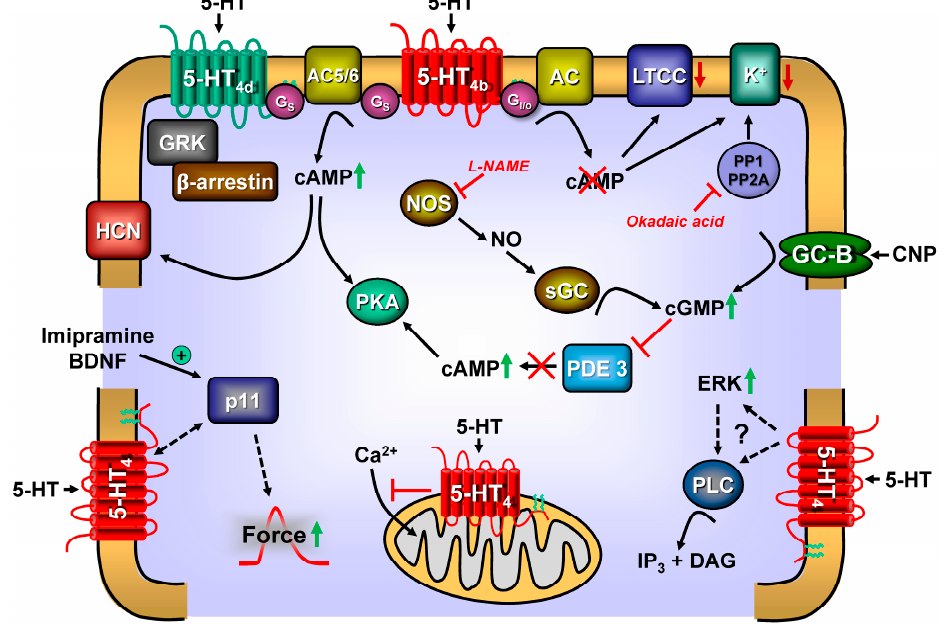
Figure 2. Synopsis of putative signal transduction of 5-HT 4 -receptors in the heart. For general information and abbreviations, see Figure 1. 5-HT 4a -receptors couples only via stimulatory G-proteins (G s ). 5-HT 4b -receptors couple via both G s and inhibitory G-proteins (G i ). The 5-HT 4 -receptors can signal via guanosine triphosphate–protein couple receptor kinases (GRK). The 5-HT 4 -receptors can be phosphorylated and inactivated via GRK. The cAMP can bind and activate a hyperpolarisation-activated cation-channel (HCN), inducing tachycardia in the sinus node of the heart. Moreover, imipramine or BDNF treatment increase the expression of PIN1. Augmented levels of PIN1 can facilitate the coupling of 5-HT 4 -receptors to force generation. The coupling of 5-HT 4 -receptors to potassium channels (K + ) is activated by PKA and reversed by the activity of serine/threonine protein phosphatases (PP1/PP2A inhibitable by okadaic acid). Via guanylyl cyclase-B (GC-B) receptor, the C-type natriuretic protein (CNP) can raise 3 ′ ,5 ′ cyclic guanosine monophosphate (cGMP) levels in cells. This cGMP can inhibit phosphodiesterase (PDE) 3 (III). If PDE 3 is inhibited, the cAMP-levels increase because degradation of cAMP is protracted. 5-HT 4 -receptors are also found on mitochondria, where they impair calcium ion influx. Nitric oxide (NO) synthase (NOS) can be phosphorylated and activated by PKA. NOS (inhibitable by L-NAME) can generate NO, which leads to the activation of a soluble guanylyl cyclase (GC), leading to the generation of more cGMP. Moreover, 5-HT 4 -receptors can activate extracellular-regulated-kinase (ERK) and increase the activity of protein kinase C via the previous activation of phospholipase C (PLC). This is achieved because PLC leads to the formation of inositol-trisphosphate (IP 3 ) and diacylglycerol (DG). DG can activate protein kinase C.